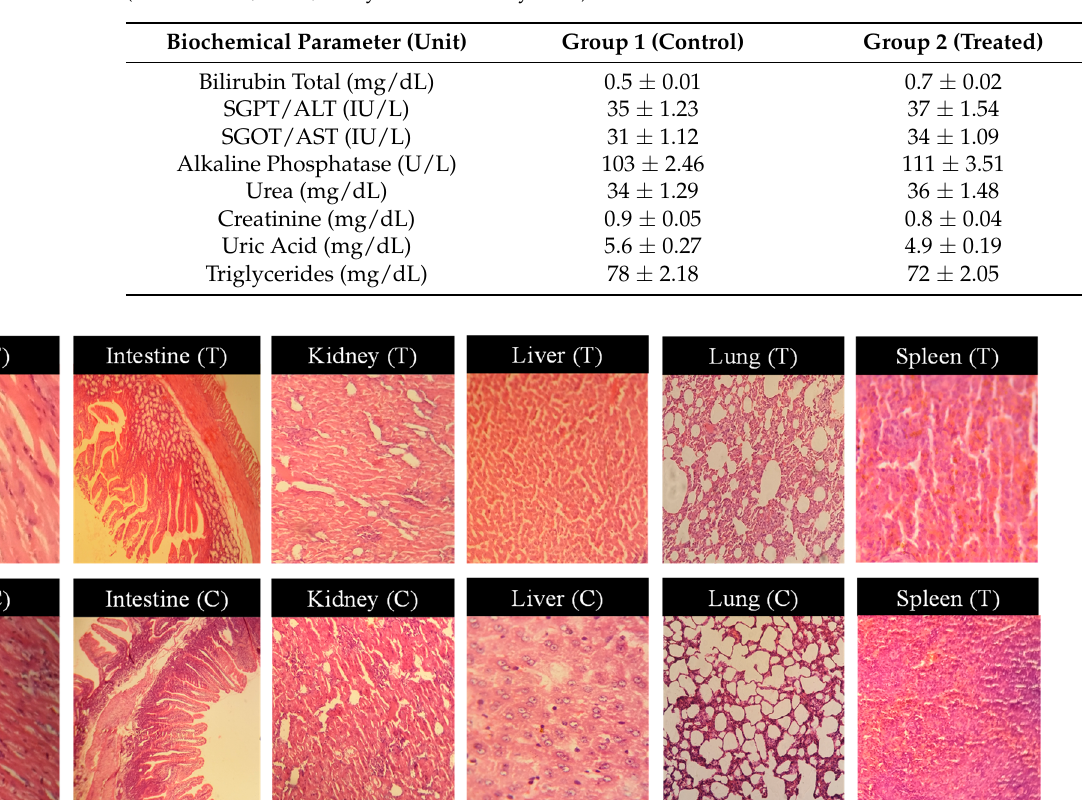
Table 6. Renal, hepatic and lipid profiles of rabbits after Ins-Mmt-hydrogel NC administration (mean ± S.D, n = 6; analysis date 27 May 2021).